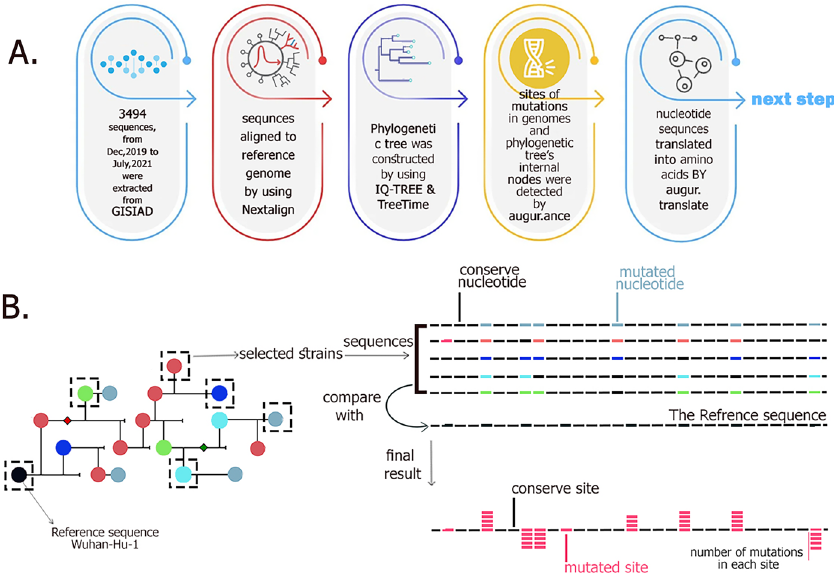
Figure 1. Schematic illustration of 5 steps to find the site of mutations and number of mutations. As illustrated in panel ( A ) number of mutations in each site of the SARS-CoV-2 genome was identified through 5 steps for the next step (finding mutations in different sites of epitopes and IDRs and quantifying their conservity). In panel ( B ), the identification of mutations and sites with comparing with the reference sequence (3rd and 4th steps) is illustrated schematically. In this example we have chosen 5 new variant sequences and compared them with the reference sequence in order to find the site of mutations and number of events in SARS-CoV-2